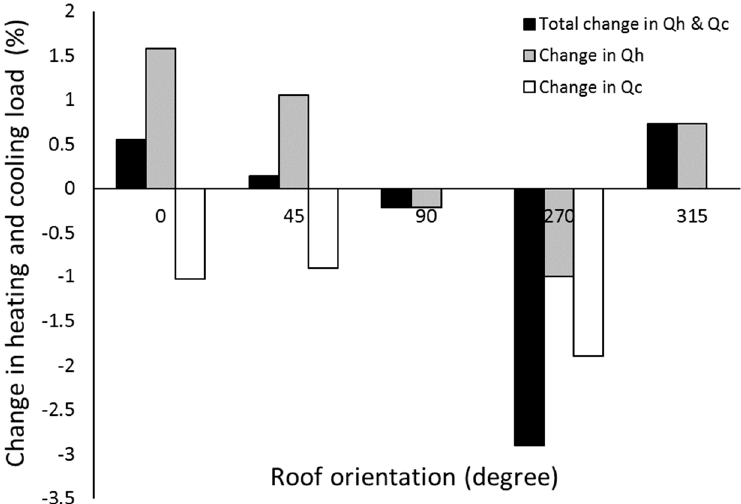
Figure 8. The percentage of change in annual heating and cooling load due to shading developed by PV panels on a gabled roof.